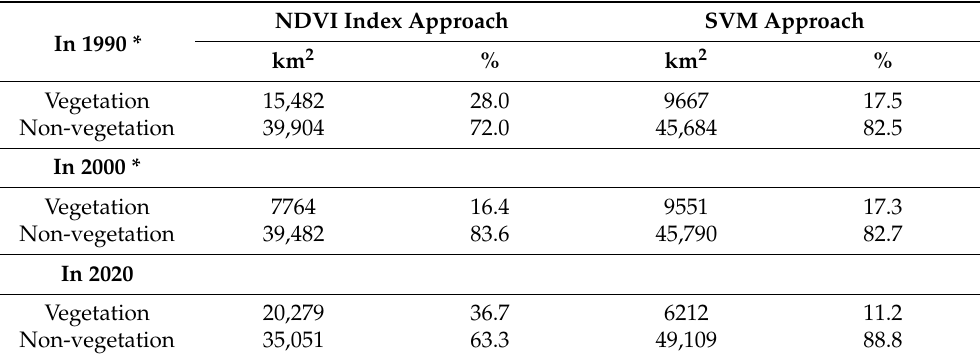
Table 7. Difference of vegetation classes in 1990, 2000, and 2020 for two classification approaches of land cover in the High Atlas Mountains of Morocco.